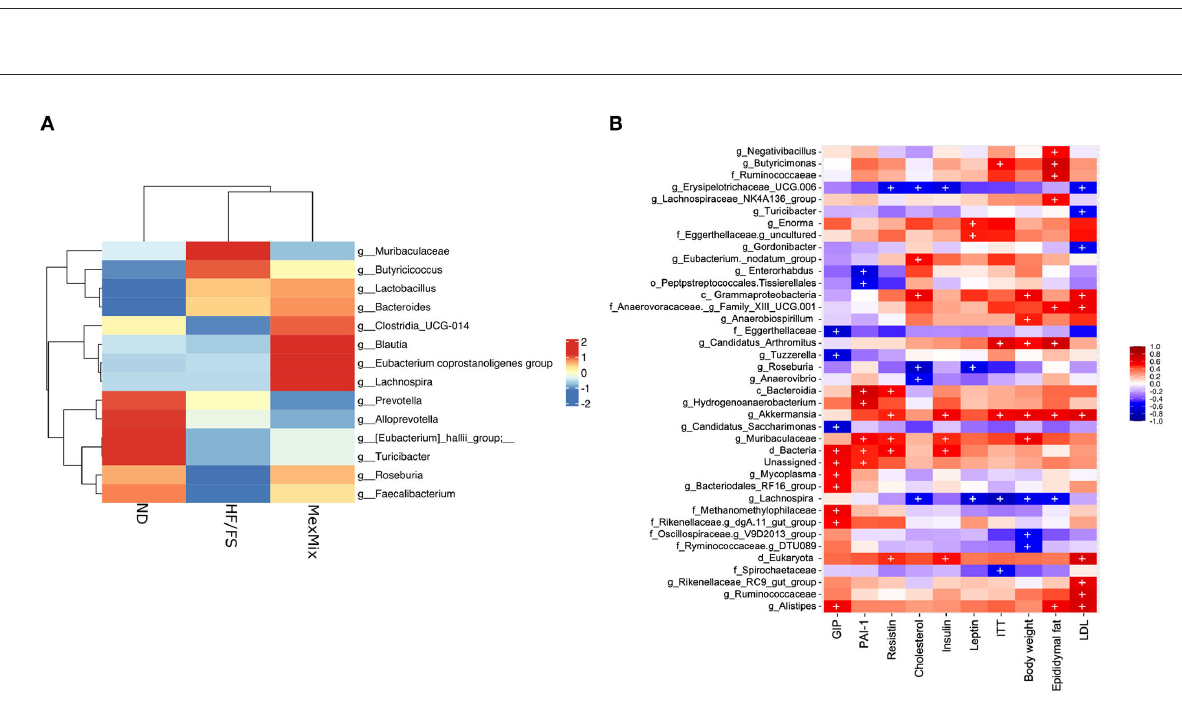
FIGURE6 (A) Heat map with relative abundance with enriched genus. (B) Heat map with Pearson’s correlation between several taxa and parameters related to glucose and lipid metabolism. Statistically significant ( p < 0.05) correlations are represented by ( +